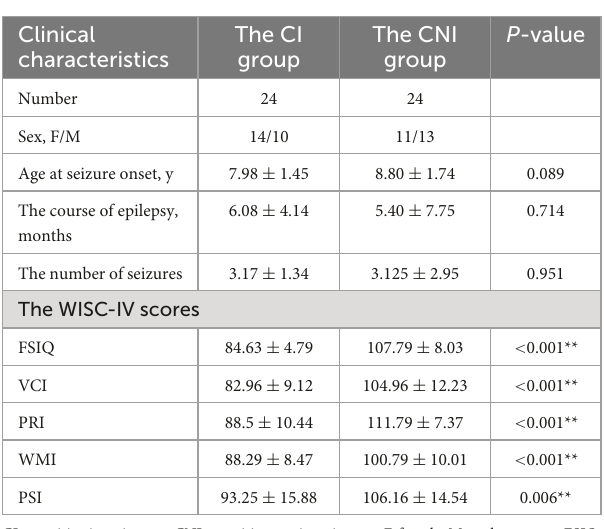
number of seizures was 3.17 ± 1.34, while it was 3.125 ± 2.95 in the CNI groups. The WISC-IV scores of BECTS with CI were: FSIQ = 84.63 ± 4.79, VCI = 82.96 ± 9.12, PRI = 88.5 ± 10.44, WMI = 88.29 ± 8.47, and PSI = 93.25 ± 15.88. The WISC- IV scores of BECTS with non-cognitive impairment included: FSIQ = 107.79 ± 8.03, VCI = 104.96 ± 12.23, PRI = 111.79 ± 7.37, WMI = 100.79 ± 10.01, and PSI = 106.16 ± 14.54. Specific